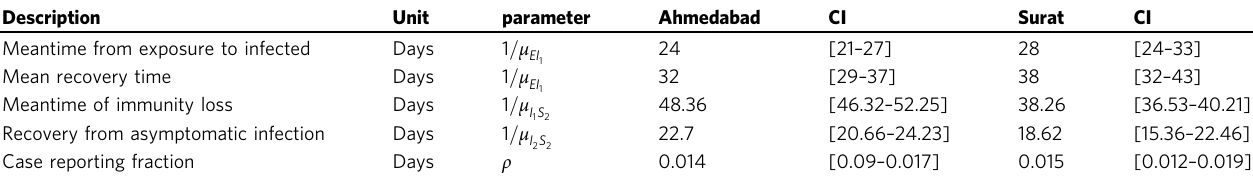
Table 2 Parameter estimates and con fi dence intervals for both cities. (The average human lifespan was fi xed at 50 years). Description Unit